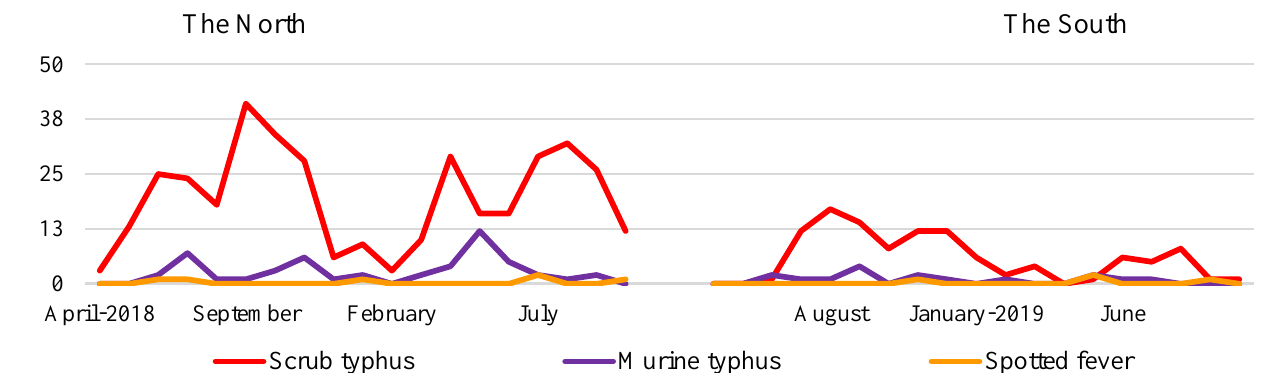
Figure 5. Frequency of Patients with Confirmed Scrub Typhus, Murine Typhus and Spotted Fever in the North and the South of Vietnam by Month.